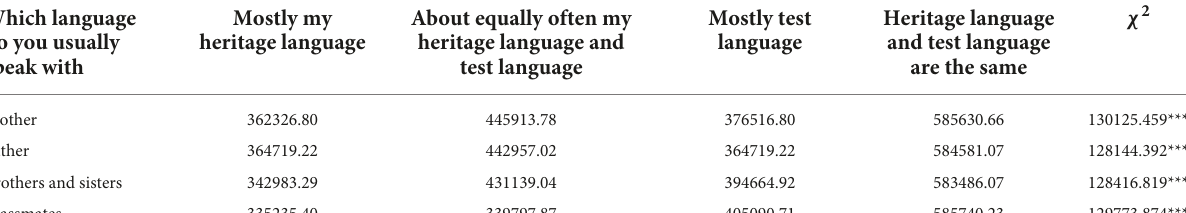
TABLE 4 Result of Kruskal-Wallis test and rank mean for all groups for language used with family members and classmates.